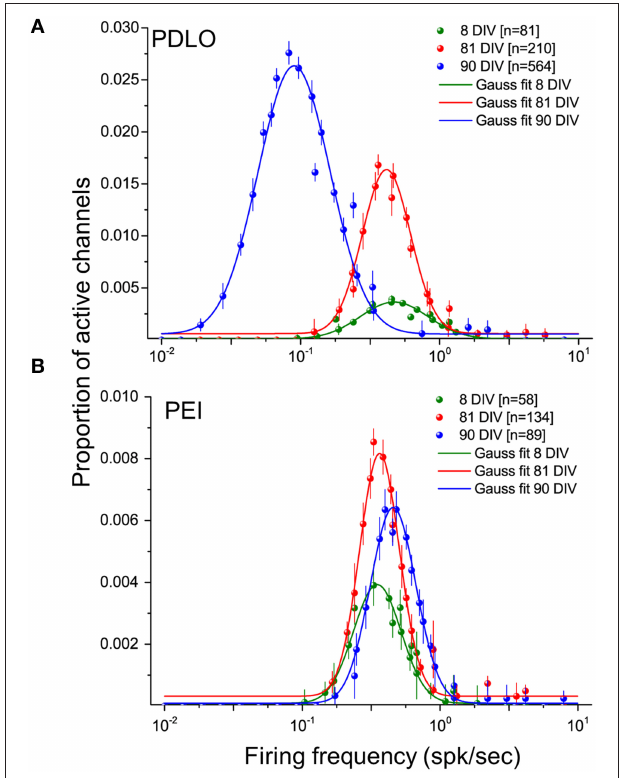
FIGURE 4 | Distributions of the firing frequencies of iCell neuronal networks is lognormal- like and allow to elucidate the dynamic behavior of human iCell neuronal networks during development.(A) Gaussian fits of the firing frequency distributions for three developmental phases of neurons grown on PDLO coated substrates, i.e., at 8, 81, 90DIV. The means of the distributions at 8 and 81DIV hold the same frequency position, but a higher peak of the distribution (red) is observed at 81DIV. At 90DIV, the mean of the distribution (blue) shifts left toward low-firing rates and the occurrence of active electrodes reaches its peak at this range of low frequency. (B) Neuronal cultures grown on PEI coated substrates hold over development the means of their lognormal-like distributions at the same frequency range (no shift). The peak of these distributions indicates a lower probability of active electrode occurrence during development compared with networks frown on PDLO coated